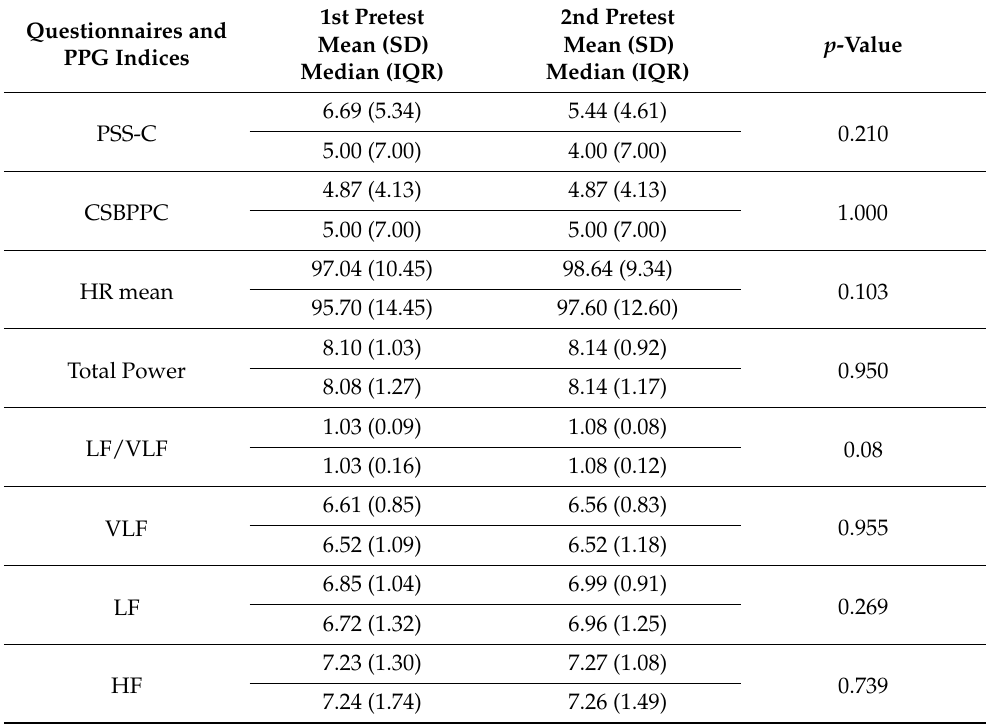
Table 2. Initial pretest